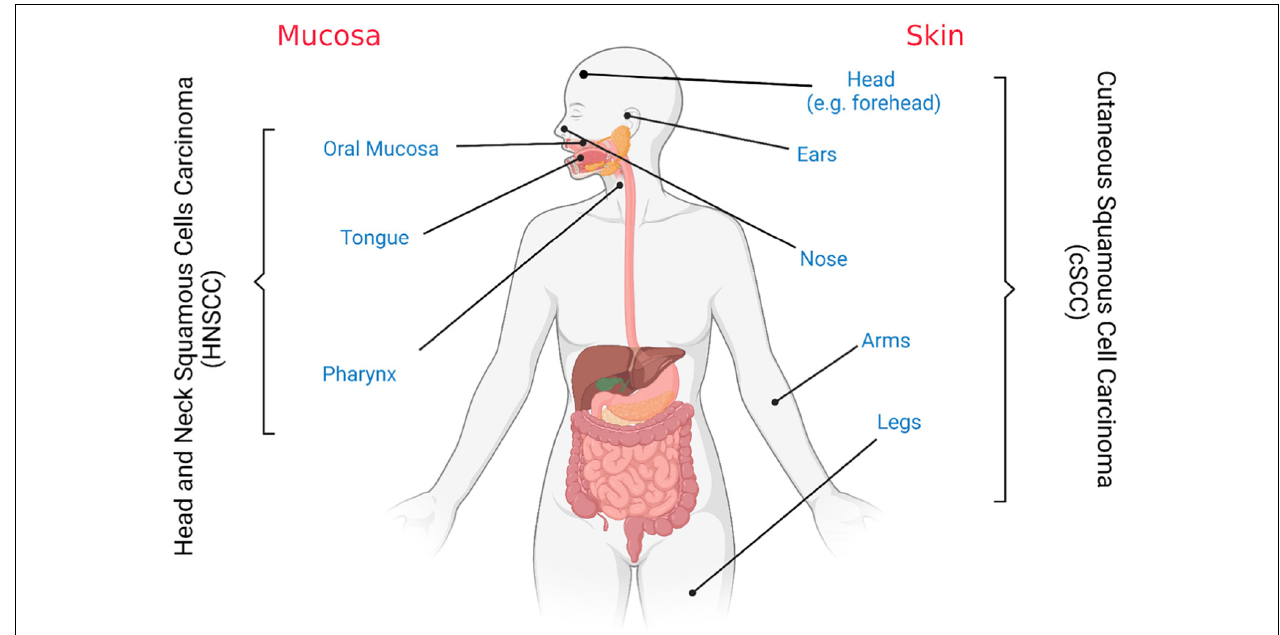
FIGURE 1 | Cutaneous and oral squamous cell carcinoma tissues of origin. Schematic representation. Figure created with